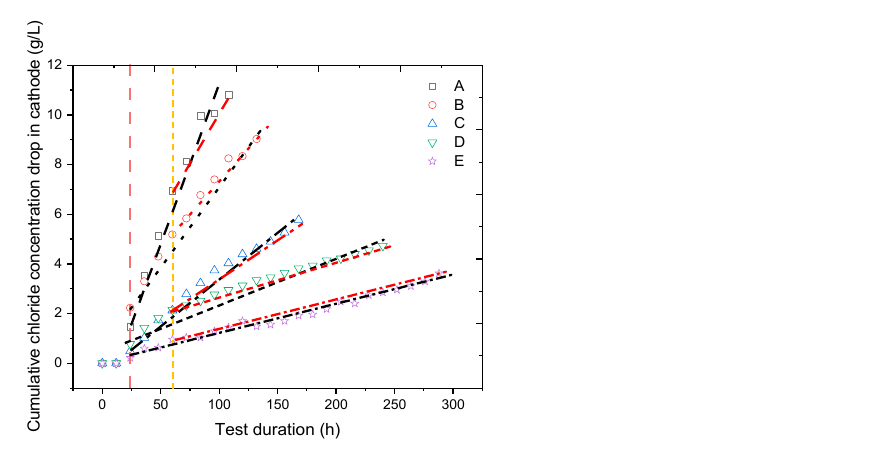
Figure 7. Cathode cumulative chloride concentration drop linear regression results of all mixtures. Table 4. Linear regression parameters for cathode chloride concentration drop of all mixtures.